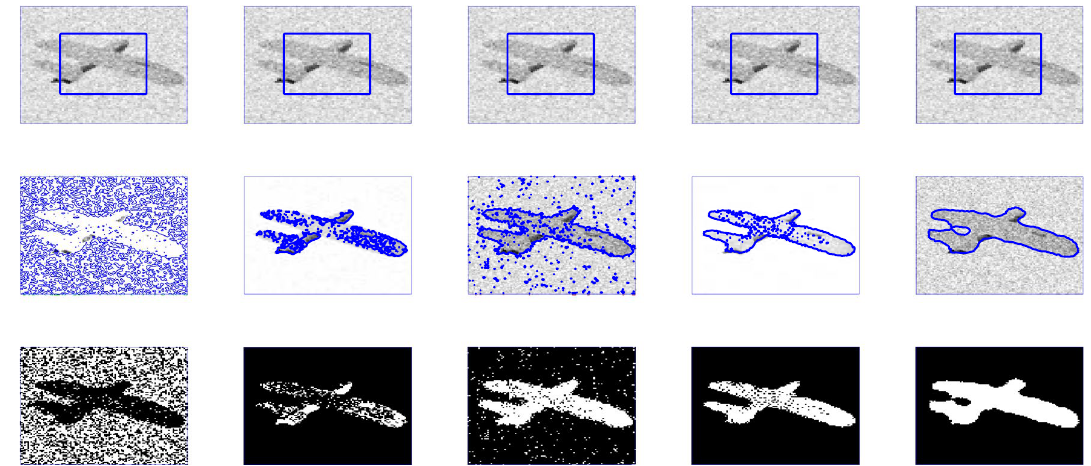
Figure 5. First row shows the given image and the zero level set initialization, the second row shows the segmentation contour and the last row the binary image resulting from the reconstruction of each method involved in the comparison. First, second, third and fourth columns are the segmentation results of Wu et al. 24 , Li et al. 15 , Wu et al. 12 and Krinidis et al. 31 , respectively. The Fifth column illustrates the result of proposed model with p = 0.5 , µ =0.7, σ =3, with speckle noise = 0.2.